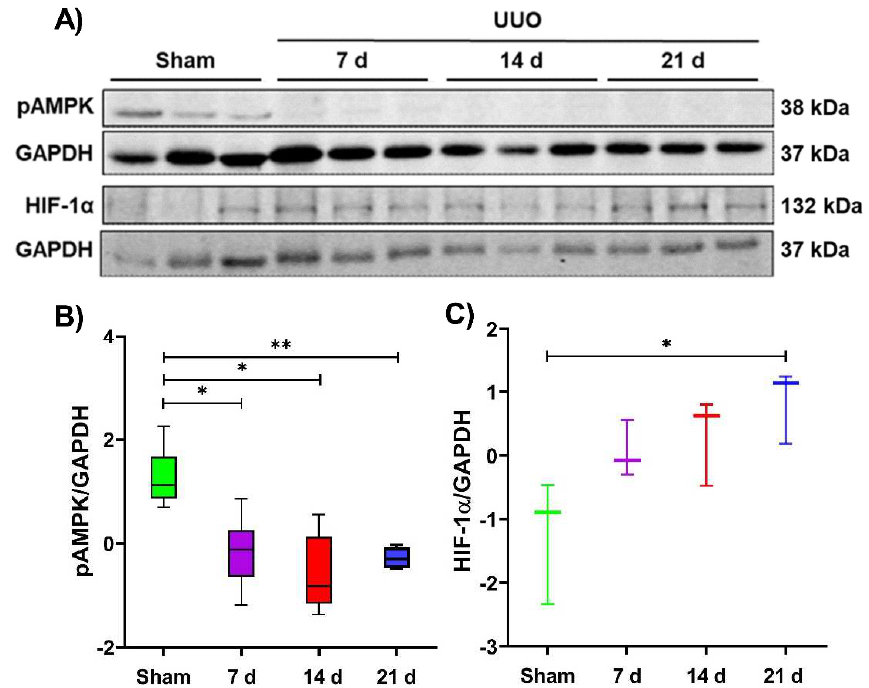
Figure 6. Metabolic reprogramming during the unilateral ureteral obstruction (UUO). ( A ) Representative blots of phosphorylated adenine monophosphate protein kinase (pAMPK) and hypoxia–inducible factor 1 α (HIF–1 α ) during 7, 14, and 21 days after UUO; glyceraldehyde 3–phosphate dehydrogenase (GAPDH) was used as a loading control. ( B ) pAMPK and ( C ) HIF–1 α statistical analysis. All Western blot measurements were performed in whole tissue lysate. Data are represented as mean ± SD of one or two technical replicates from three rats per group; each technical replicate was standardized Z(µ = 0, σ). * p < 0.05, ** p < 0.01.